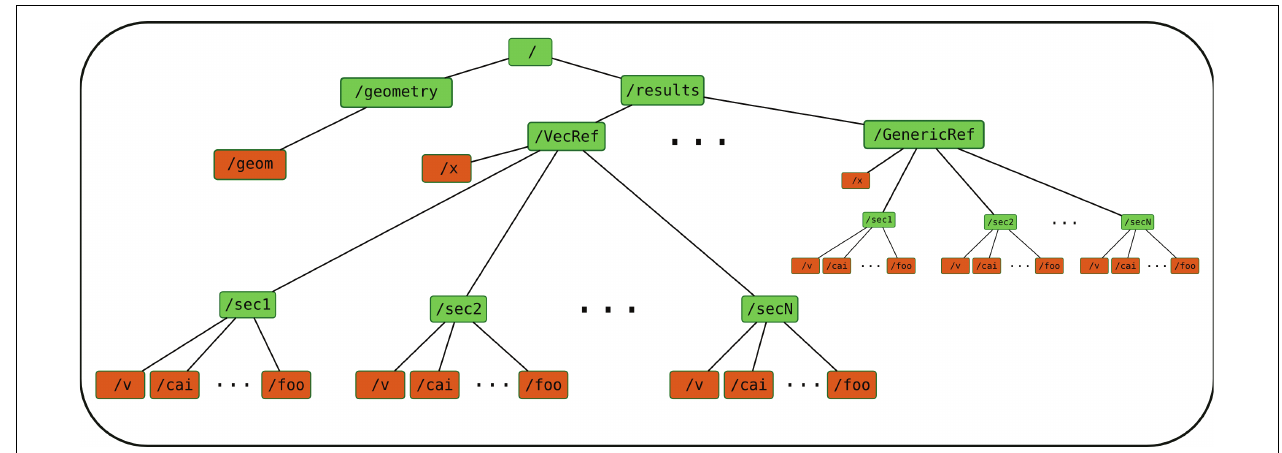
FIGURE 5 | Structure of the HDF5 file used to store the computational results of a simulation. The data tree is composed of two branches: the geometry branch stores the NeuroML representation, the results branch stores computed arrays resulting from the